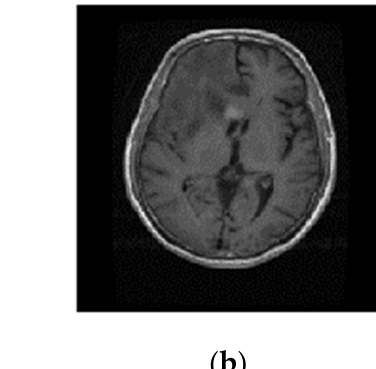
Figure 3. Normalized and resized Glioma MRI scans ( a ) Original (512 × 512), and ( b ) normalized and resized (224 × 224) .